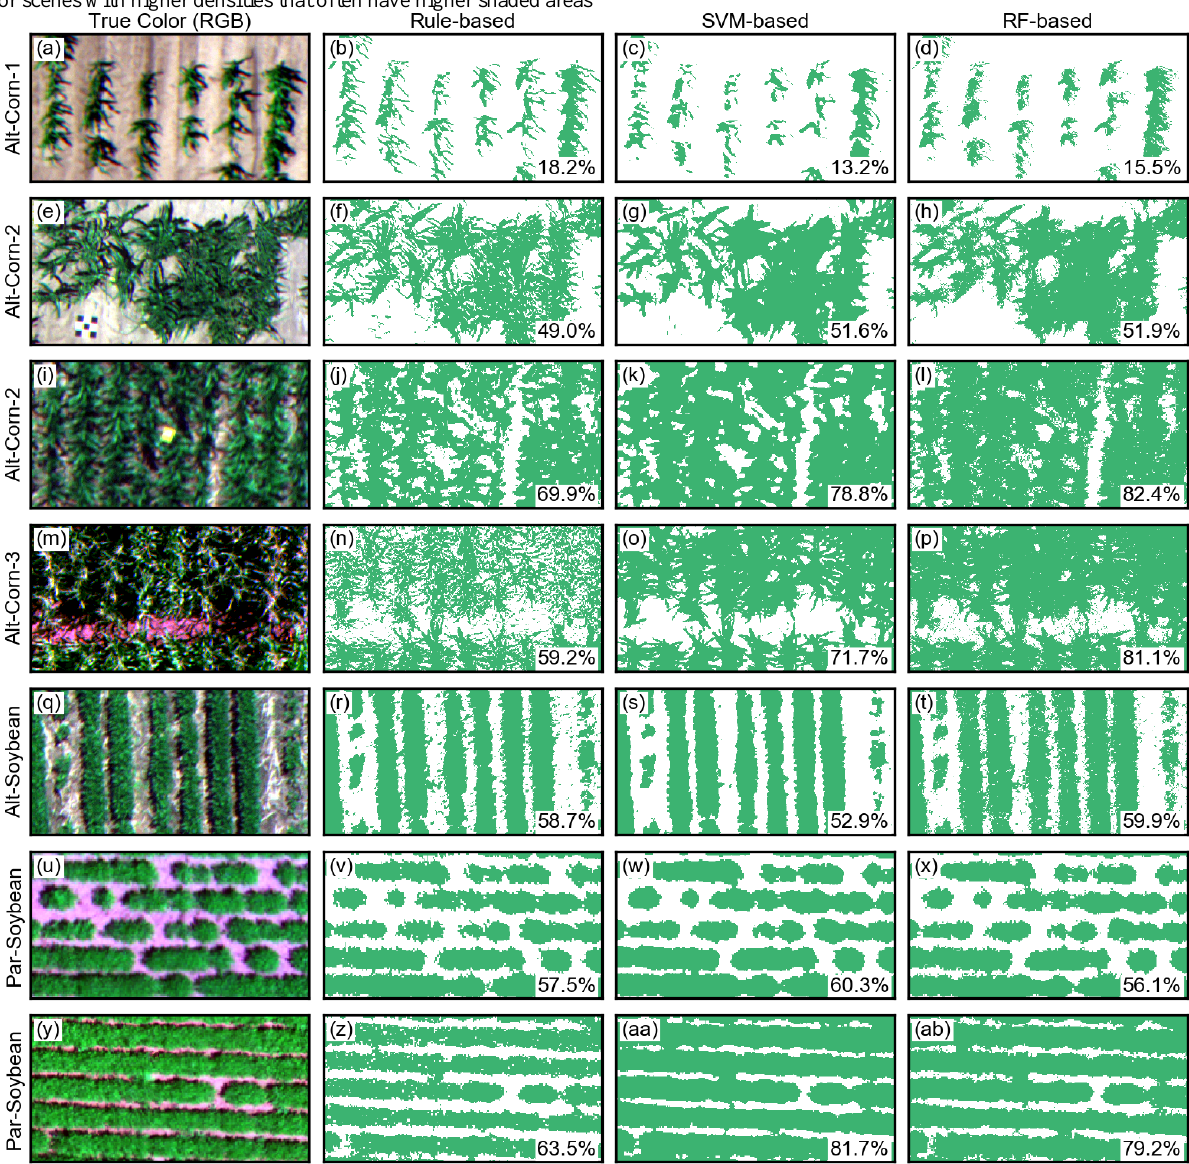
Figure 4. Visualization of classification results and estimated canopy cover for multispectral image scenes; Alt-Corn-1, Alt-Corn-2 and Alt-Corn-3 represent UAV-based Altum multispectral images collected from three different cornfields named Corn-1, Corn-2 and Corn-3; Alt-Soybean represents Altum multispectral image from a soybean field; Par-soybean are Parrot multispectral images from a soybean